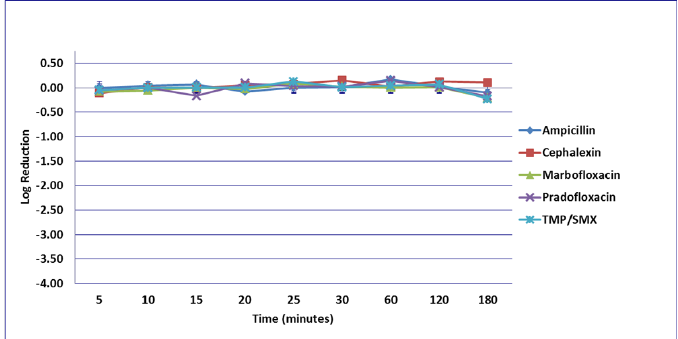
Figure 13. Log 10 reduction in S. pseudintermedius with bacterial cells exposed to ampicillin, cephalexin, marbofloxacin, pradofloxacin, and trimethoprim/sulfamethoxazole at the minimum inhibitory drug concentration. Data points present mean ± standard deviation.